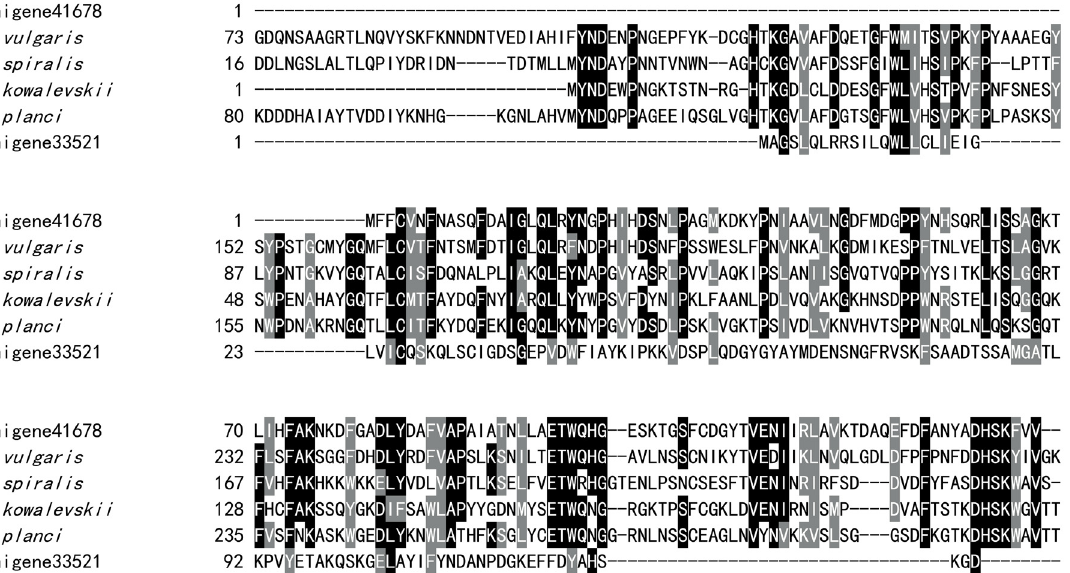
Fig 6. Alignment of plancitoxin-1-like proteins. The aligned sequences are as follows: Acanthaster planci plancitoxin 1 (BAD12432), Saccoglossus kowalevskii plancitoxin 1-like (XP_006823536), T . spiralis plancitoxin1-like protein (AHM10158) and Hydra vulgaris plancitoxin 1-like (XP_004209299). Black and gray indicate amino acids that are identical or highly conserved, respectively, across all aligned sequences.